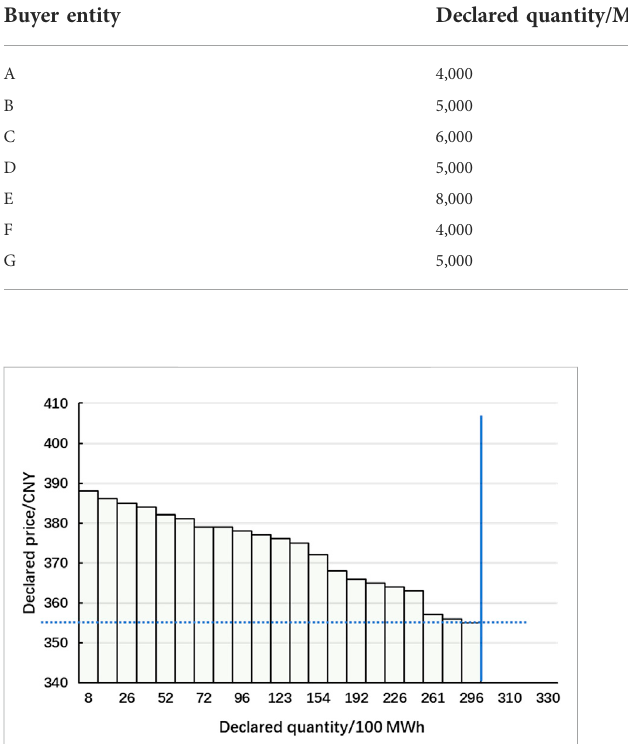
TABLE 3 Buyer ’ s winning bid of Scenario 1.